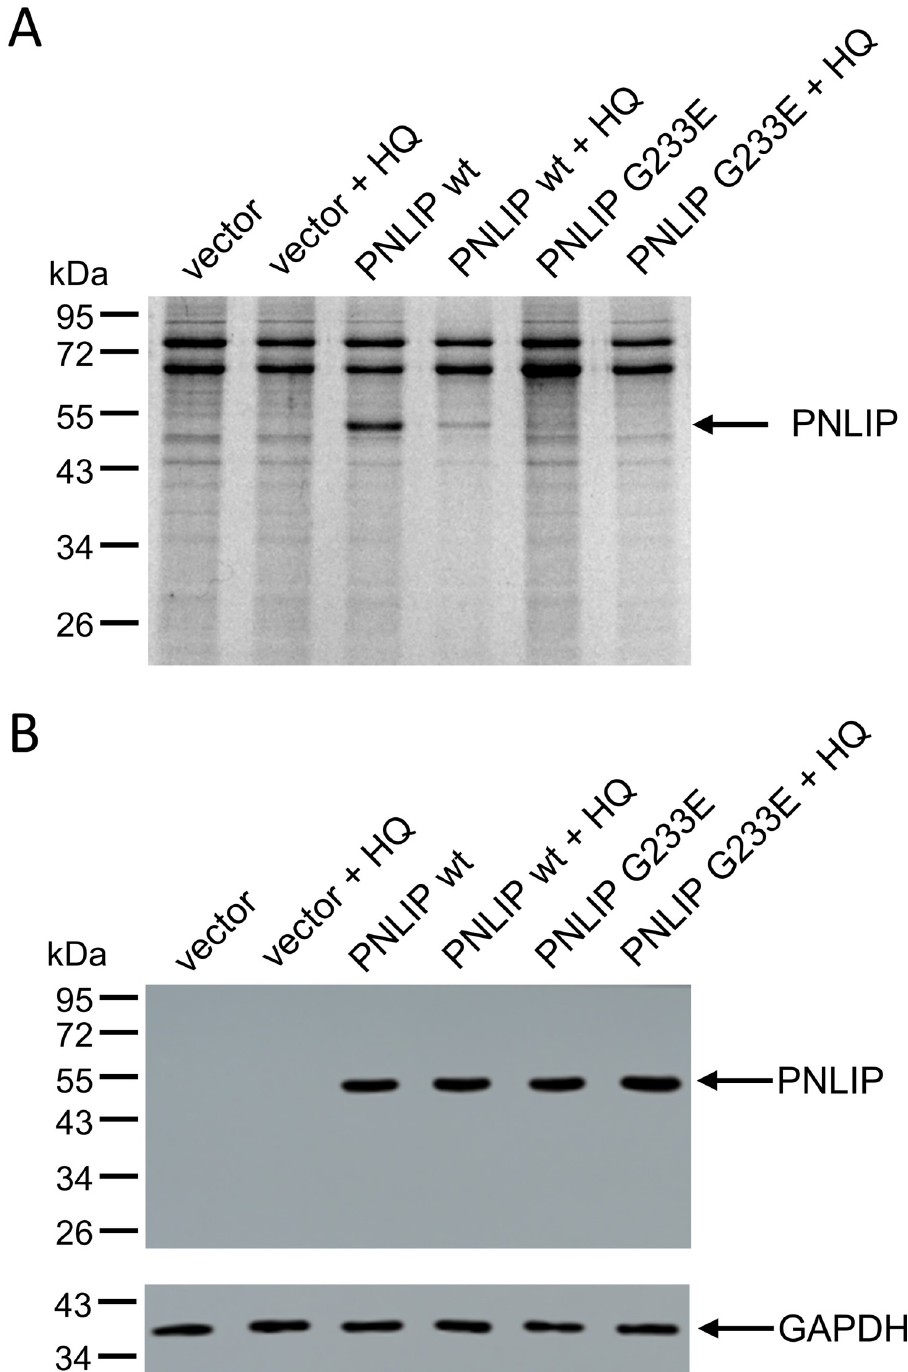
Fig 2. Effect of hydroquinone (HQ) on PNLIP secretion in HEK 293AD cells. One day post-transfection, cells were incubated in the absence or presence of 25 μ M HQ for 24 h at 37 ˚C. A) PNLIP protein in the conditioned media was analyzed by SDS-PAGE and Coomassie staining as described in Materials and Methods. B) PNLIP and GAPDH proteins in cell lysates were monitored by SDS-PAGE and immunoblotting as described previously [16].